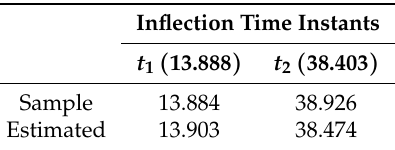
Table 7. Example 2. Sample and estimated inflection time instants for the model chosen. Theoretical are in